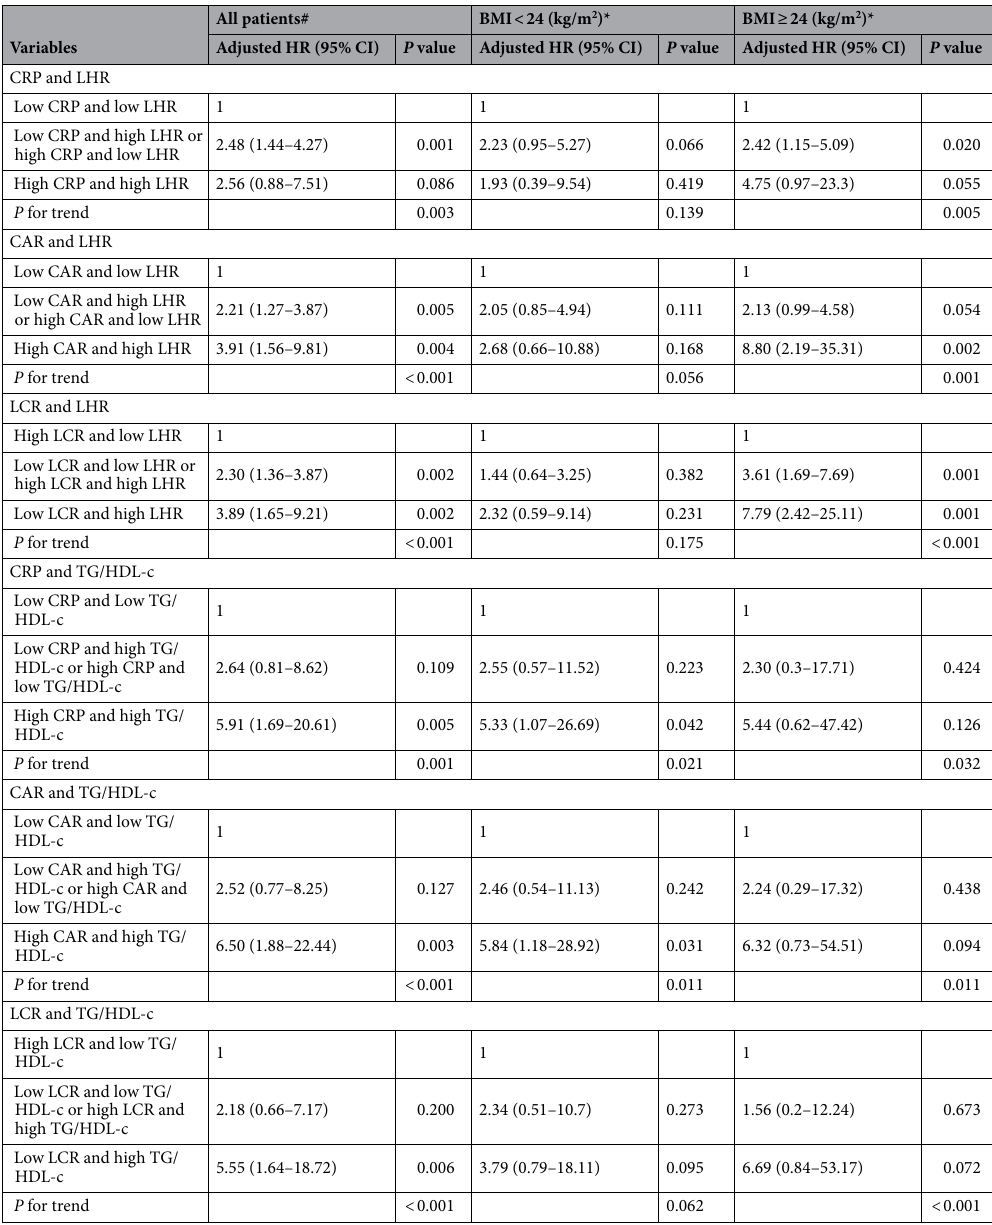
Table 4. Combined survival analysis of prognostic systemic and IR indicators. CRP C-reactive protein, LHR LDL-c/HDL-c ratio, HDL-c high-density lipoprotein cholesterol, LDL-c low-density lipoprotein cholesterol, HR family history of cancer, tumor metastasis, diabetes, hypertension, coronary heart disease, and